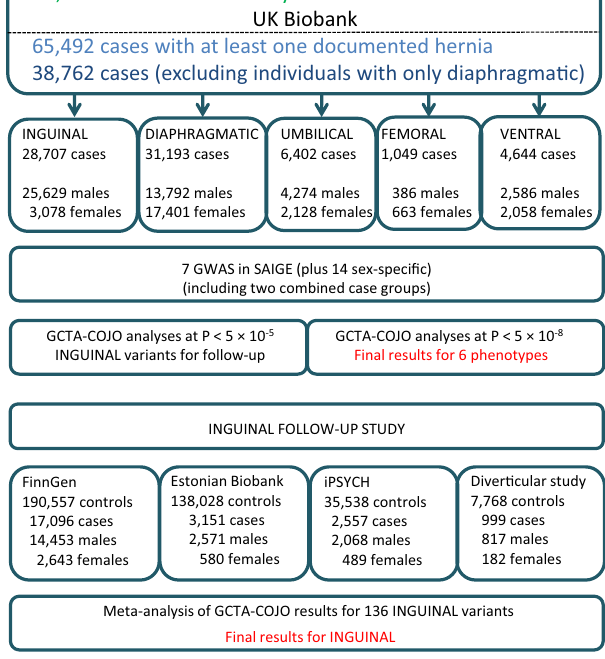
Fig. 1 Outline of this study. Study design and sample sizes for the study